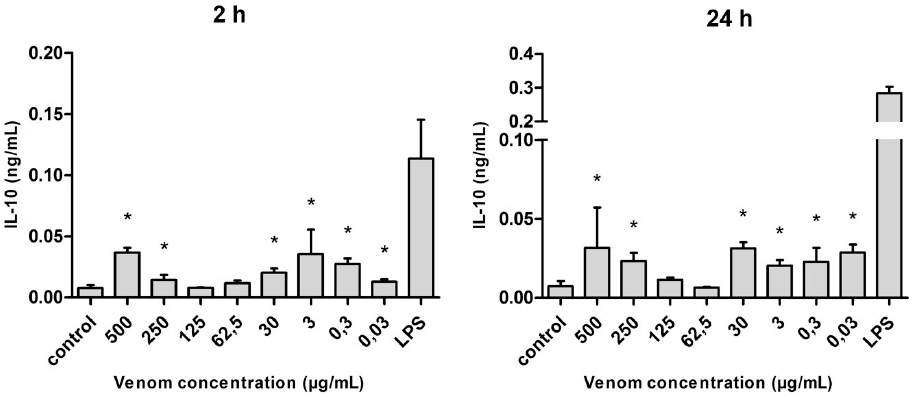
Figure 8. Amount of IL-10 (in ng/mL) released after the stimulus with Neoponera villosa venom. Values expressed in mean + standard deviation. Control: macrophages with supplemented culture medium alone. LPS: macrophages stimulated with 2 μ g/mL LPS. * Denotes significantly different ( p < 0.05).